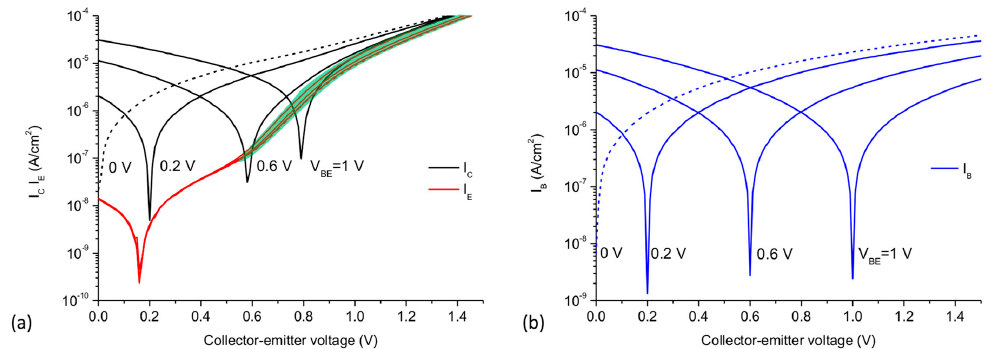
Figure 4. ( a ) Collector, emitter and ( b ) base currents versus V CE . The current dips at I B corresponds to a leveling of the collector and base Fermi levels ( V BC = 0